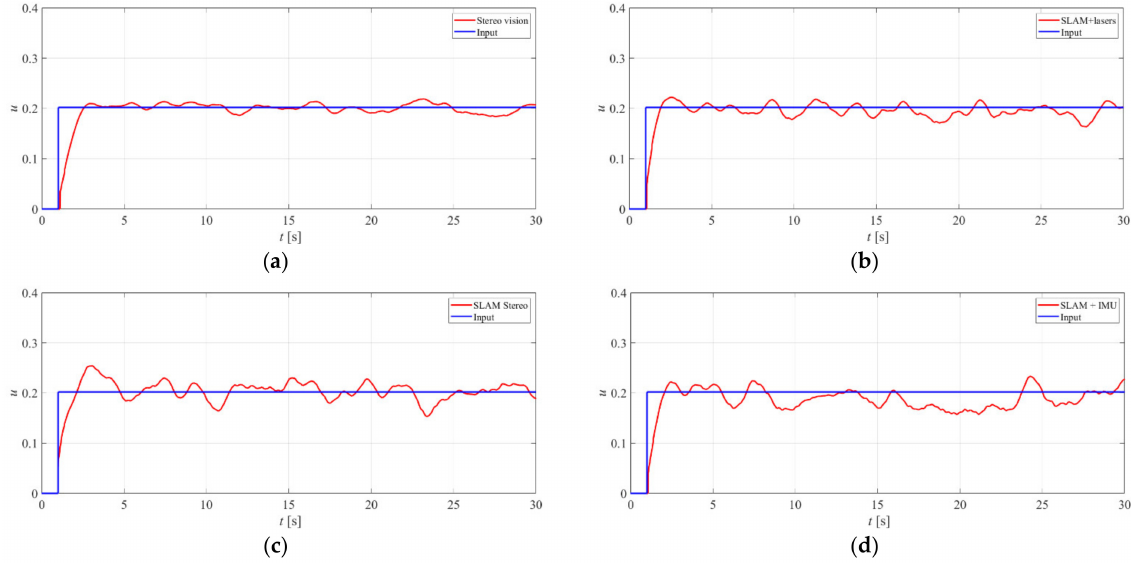
Figure 18. Surge control at constant speed equals 0.2 m/s: ( a ) stereo vision; ( b ) SLAM lasers; ( c ) SLAM stereo; ( d ) SLAM IMU. Table 3. Integral of absolute error for surge